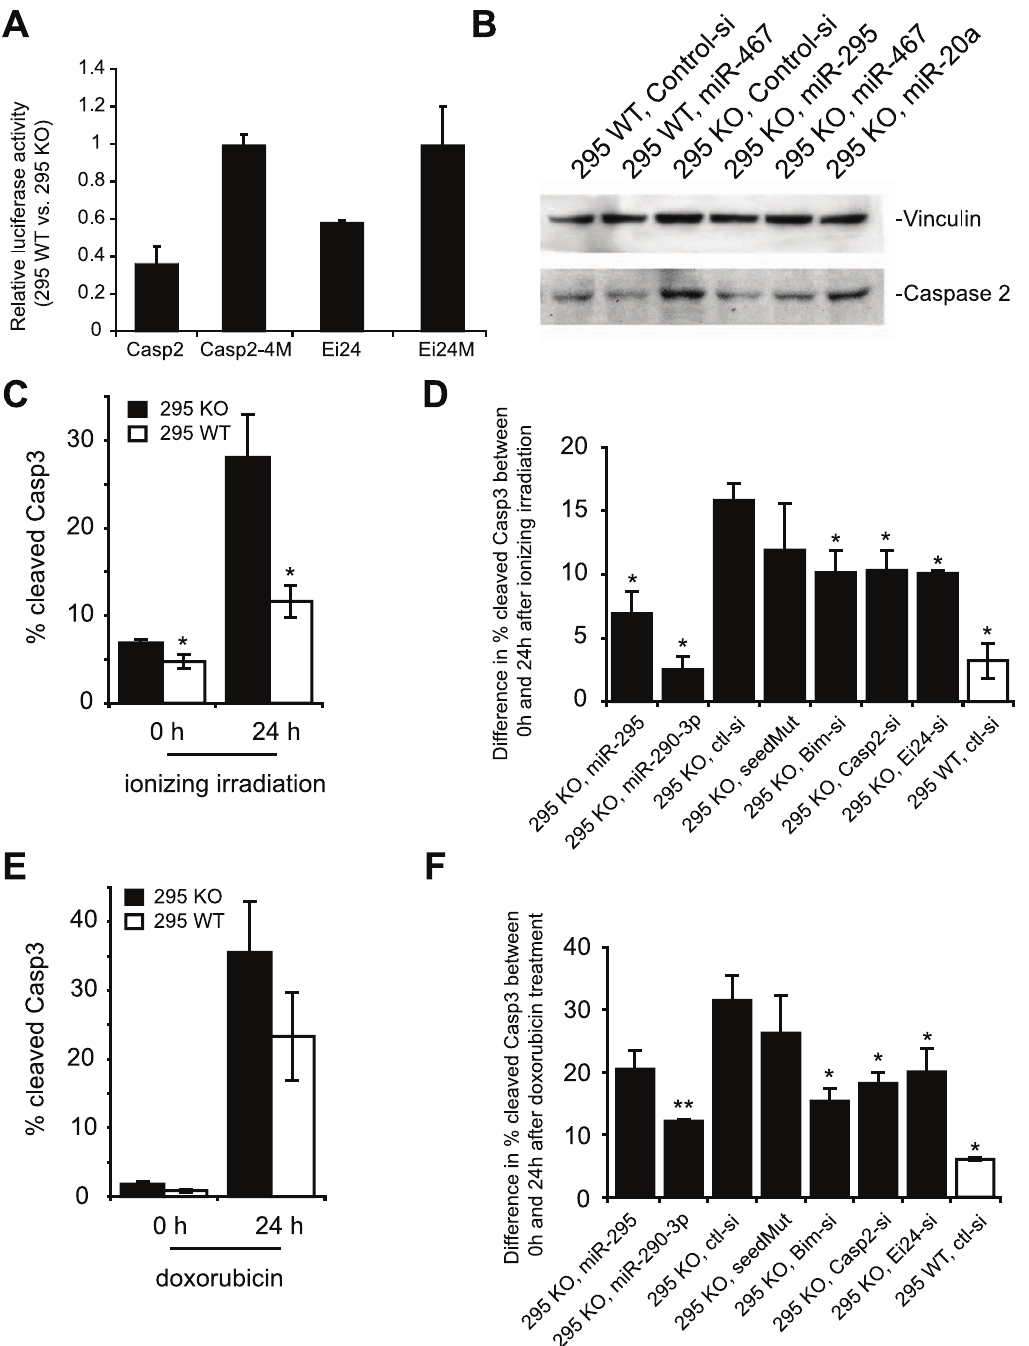
Figure 5. Loss of the mir-295 cluster derepresses Casp 2 and Ei24 3’ UTRs and enhances sensitivity to DNA damaging agents. A. Luciferase reporters with full length versions of the Casp2 3’ UTR or Ei24 3’ UTR, as well as their seed mutant versions were assayed in 295 WT and 295 KO ES cells. B. Western blot of Casp2 in 295 WT and 295 KO ES cells. 50 nM miR-295, miR-467a, and miR-20a were transfected into 295 KO ES cells, and Casp2 protein expression was assayed 24 hours after the transfection. C. The percentage of cells with cleaved Casp3 in 295 WT and 295 KO ES cells after exposure to 5-Gy radiation (0 and 24 hours after radiation treatment). Cleaved Casp3 was assayed by flow cytometry, and was used to estimate apoptotic response. Apoptosis of 295 KO cells is shown in black bars, and that of 295 WT cells is shown in white bars. D. Cells were transfected with 50 nM siRNAs as shown, and difference in apoptotic response of 295 WT and 295 KO ES cells 24 hours after exposure to 5-Gy radiation was plotted. E,F. A similar series of experiments was performed on 295 WT and 295 KO cells after exposure to 100 nM doxorubicin. n $ 3 for all experiments. Results are shown as mean 6 S.E.M. (standard error of the mean). P-values were results of Mann-Whitney tests, and * denotes p # 0.05, and ** denotes p #